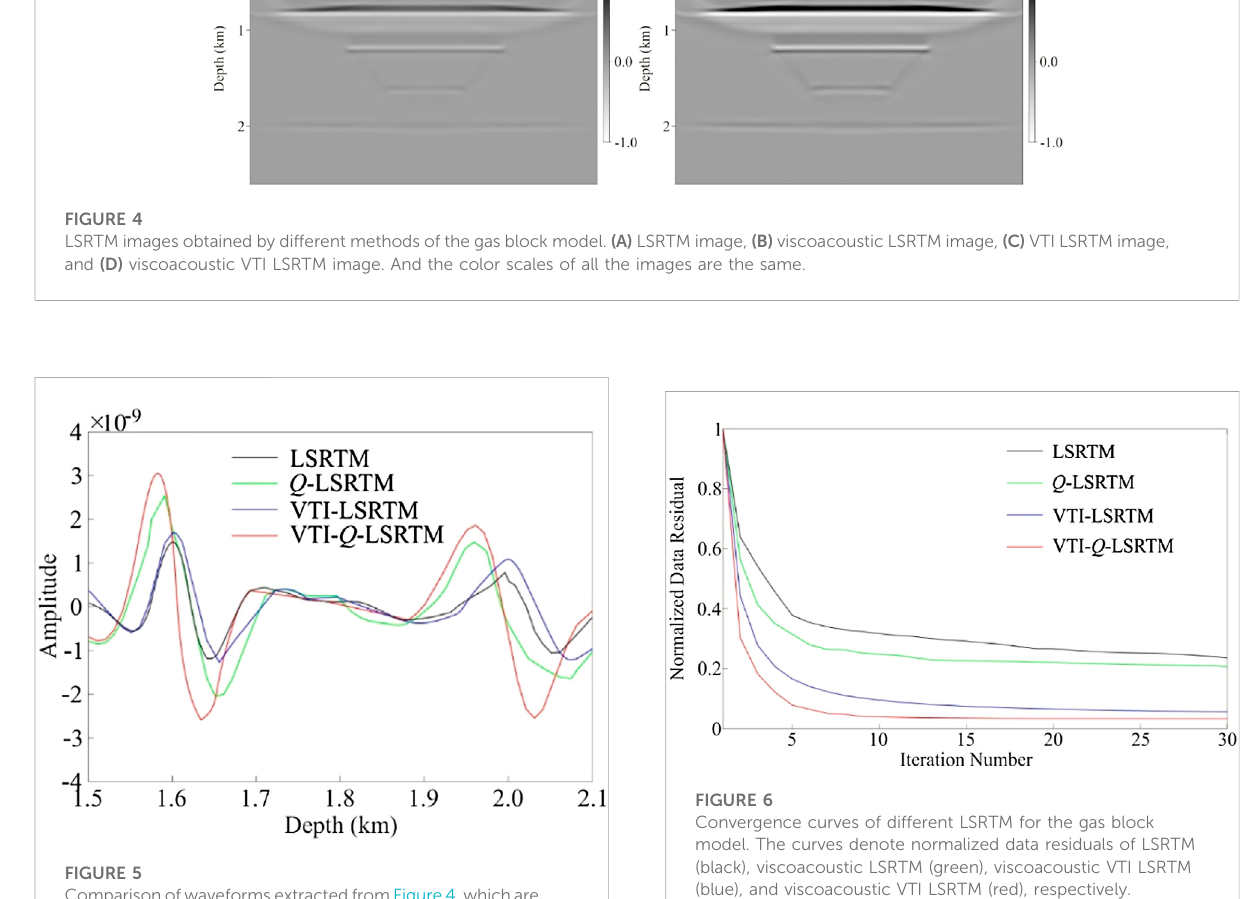
FIGURE 6 Convergence curves of different LSRTM for the gas block model. The curves denote normalized data residuals of LSRTM (black), viscoacoustic LSRTM (green), viscoacoustic VTI LSRTM (blue), and viscoacoustic VTI LSRTM (red),